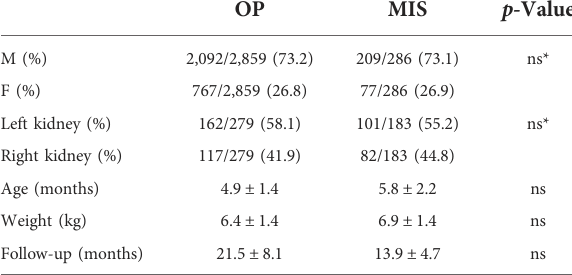
TABLE 2 Demographic data of papers included in the meta-analysis.